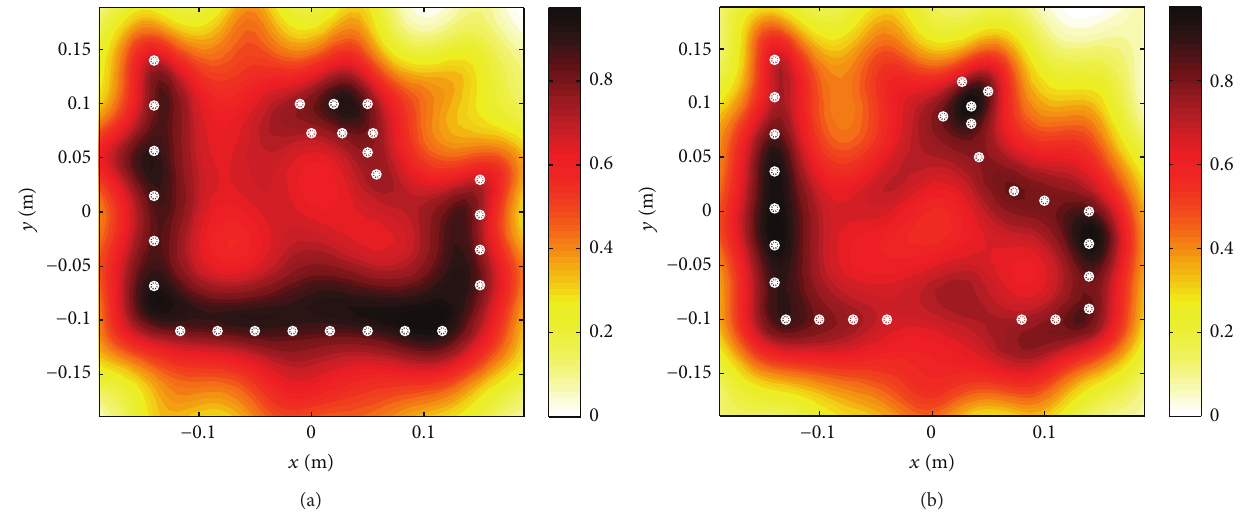
Figure 7: Example 2: LSM reconstructions by using measurement configuration B and corresponding pivot points. (a) Square scanner and (b) triangular